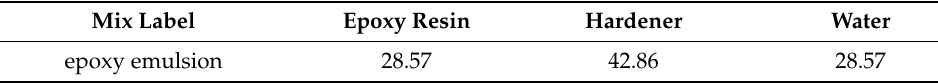
Table 1. Mix proportions of epoxy latexes (wt %).